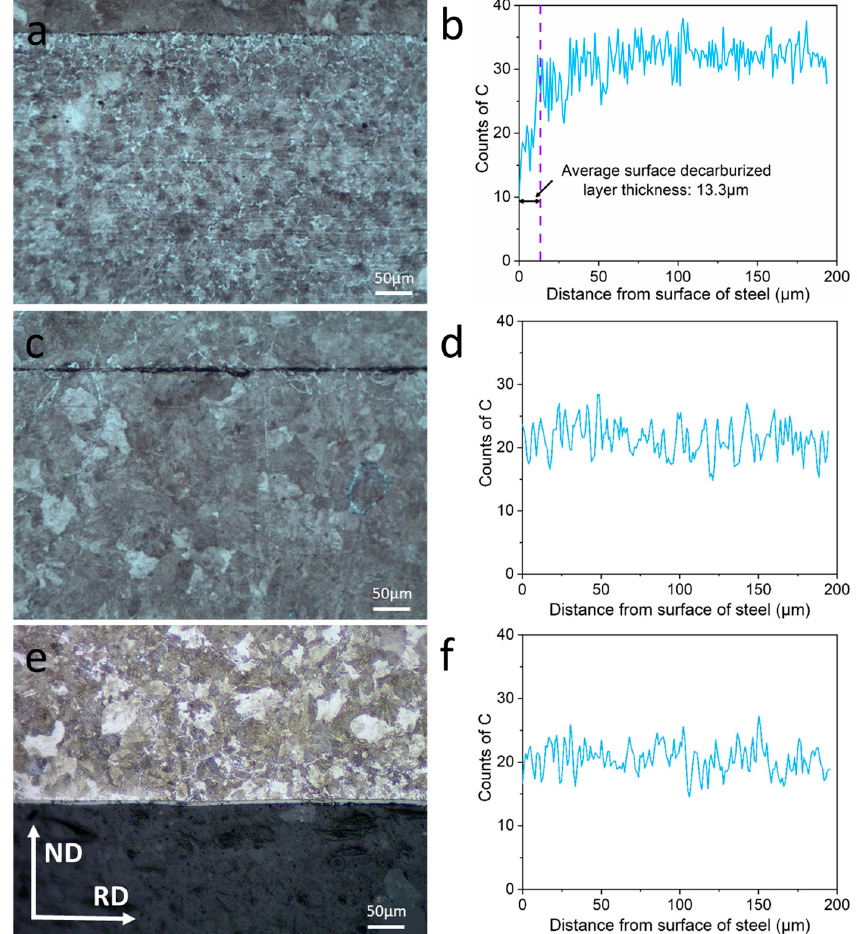
Figure 3. Optical micrographs and EPMA composition profiles of C from surface to inside of the hot-rolled strips. ( a , b ) CSP-50#. ( c , d ) TRC-50#-10. ( e , f ) TRC-50#-33.